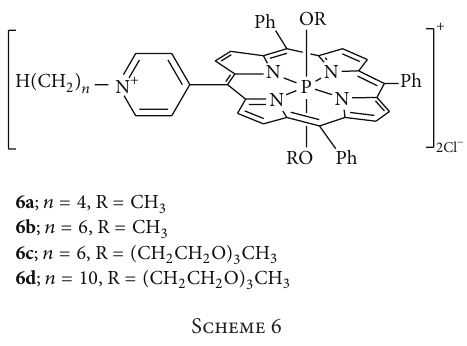
Figure 2: Dependence of [ P ]